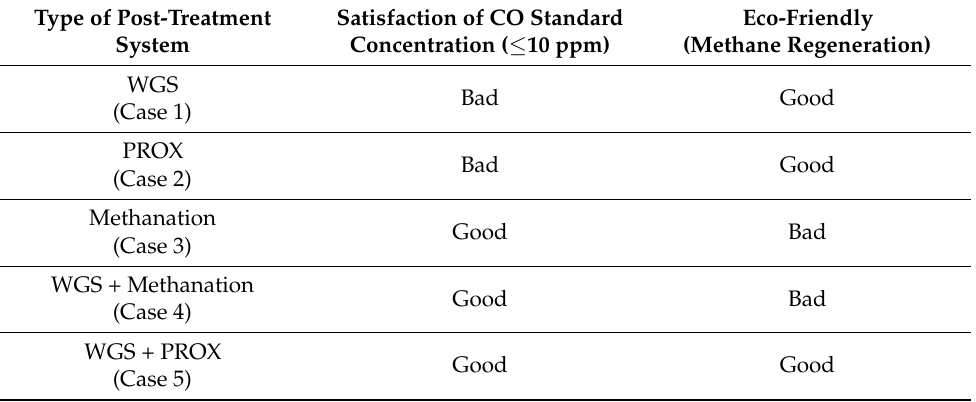
Table 9. Scores for each